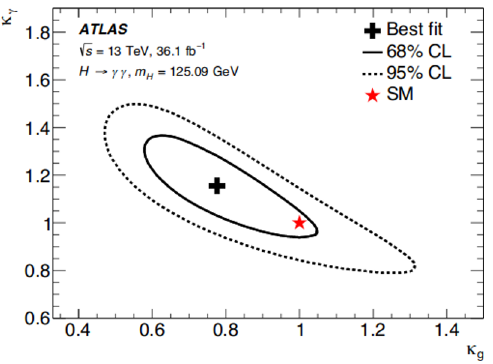
Figure 3 . Likelihood contours in the κ γ - κ g plane from ATLAS data [7]. All other coupling modifiers are fixed to the SM